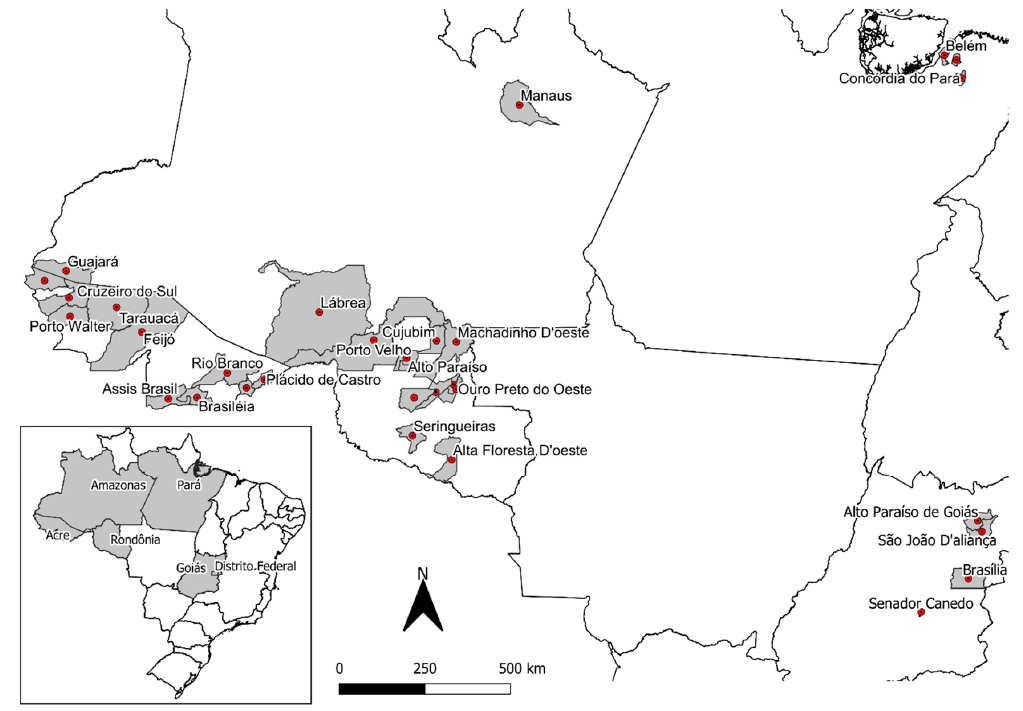
Figure 2. Collection points of Banisteriopsis caapi and other species in Brazil.